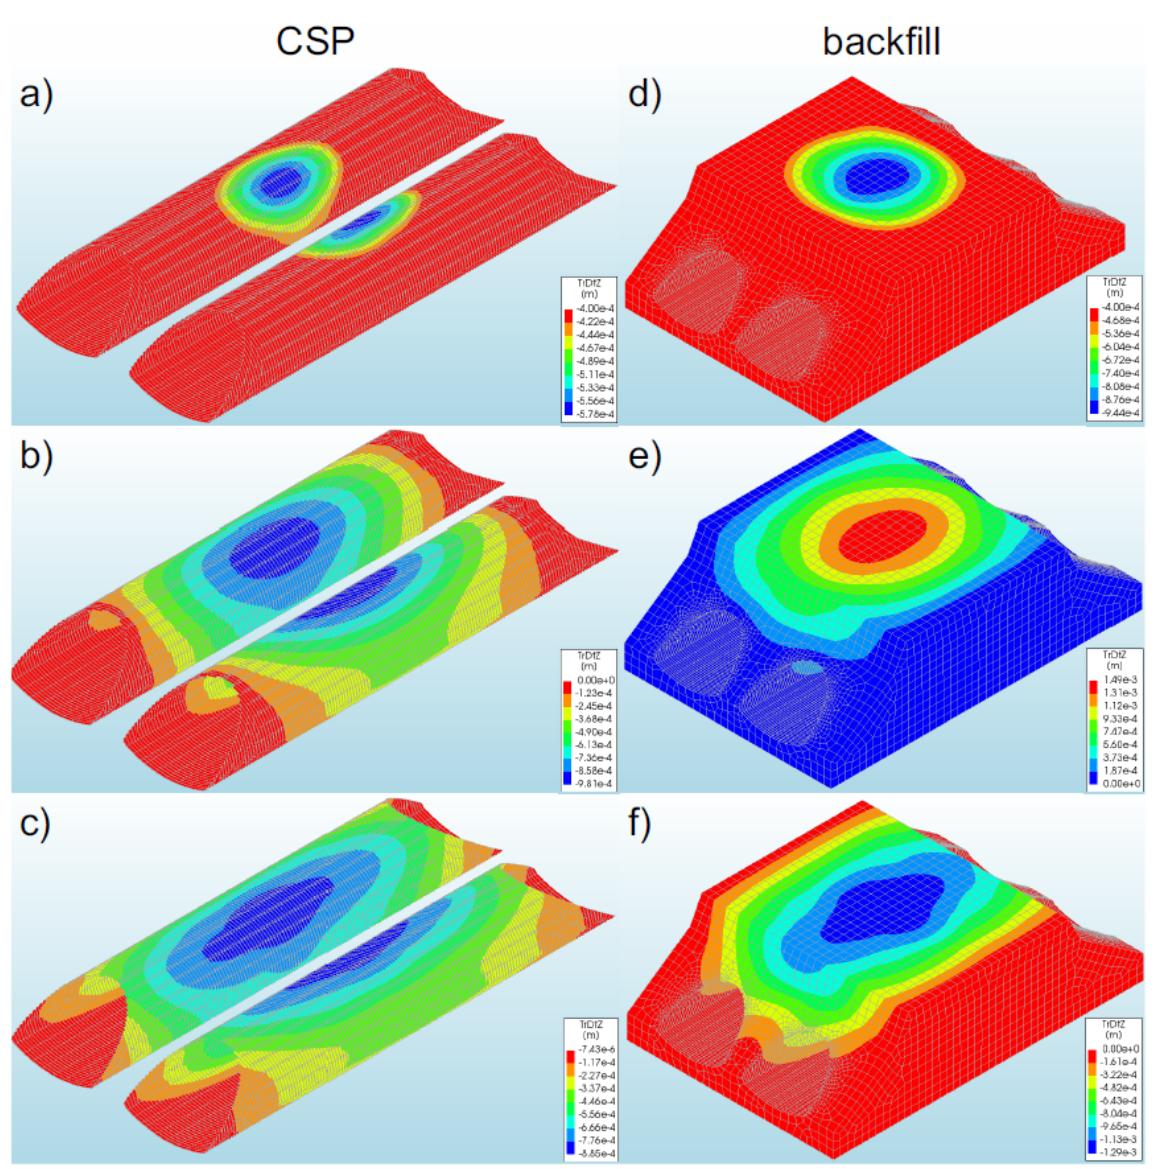
Figure 13. Distribution of the maximum vertical displacements for bridge #II in the steel shell and backfill for model 4 ( a , d ), model 5 ( b , e ), and model 6 ( c , f ). The greatest range of the displacement was recorded in model 6 (Figure 13c).